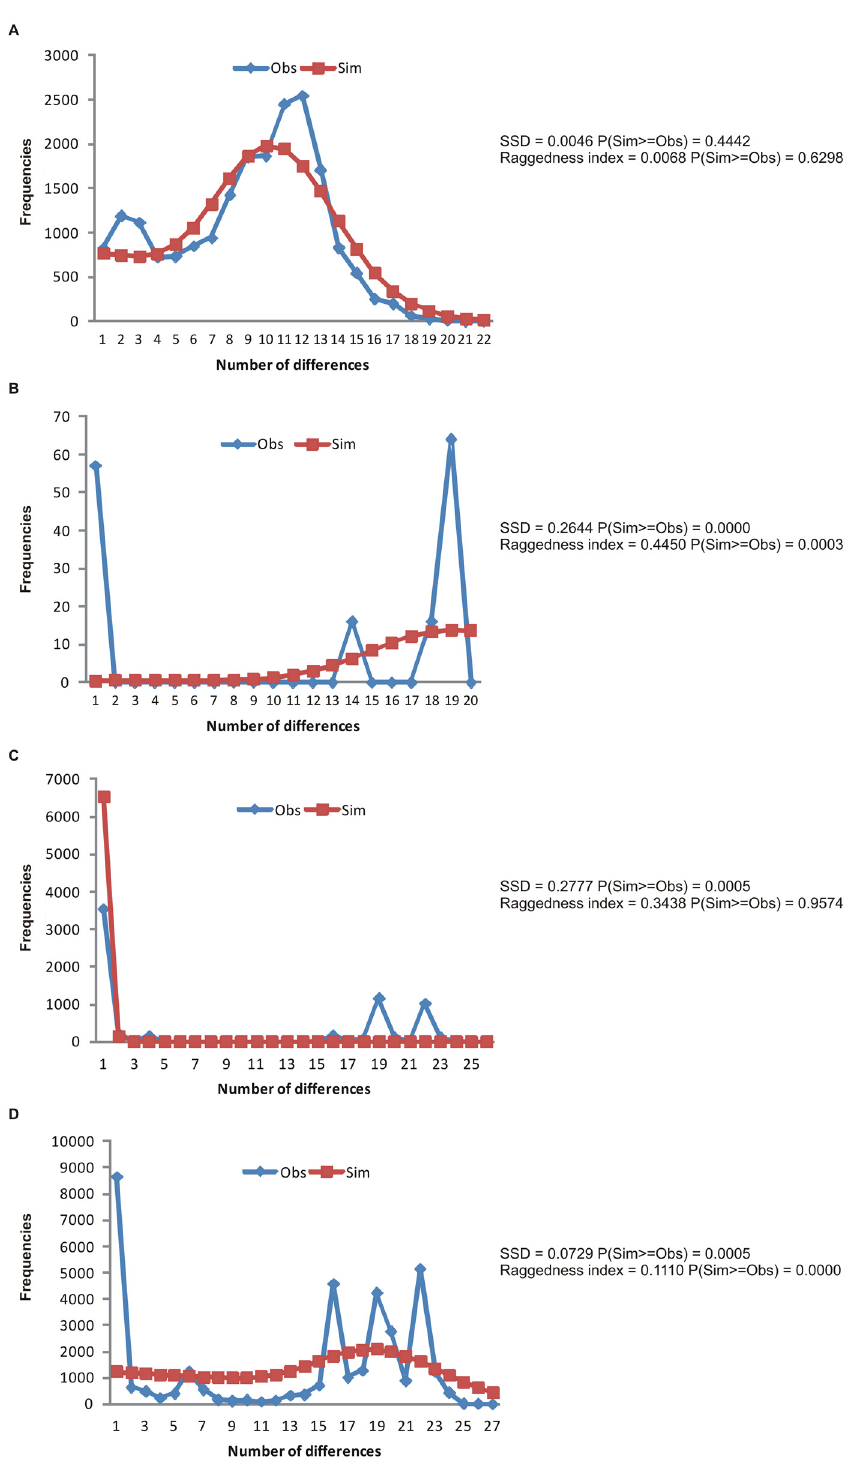
Fig 3. Mismatch distribution analyses results. (A) Mitochondrial sequences considering the complete sample in a group. (B) Ch α E7 sequences considering Group I. (C) Ch α E7 sequences considering Group II. (D) Ch α E7 sequences considering Group III from SAMOVA,